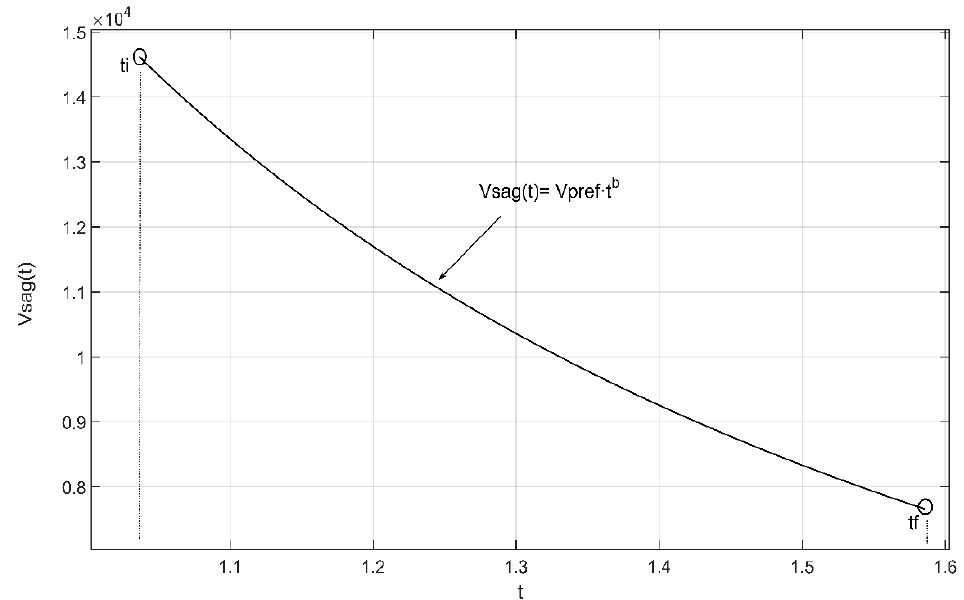
Figure 6. Voltage sag analytical function for a given b parameter.